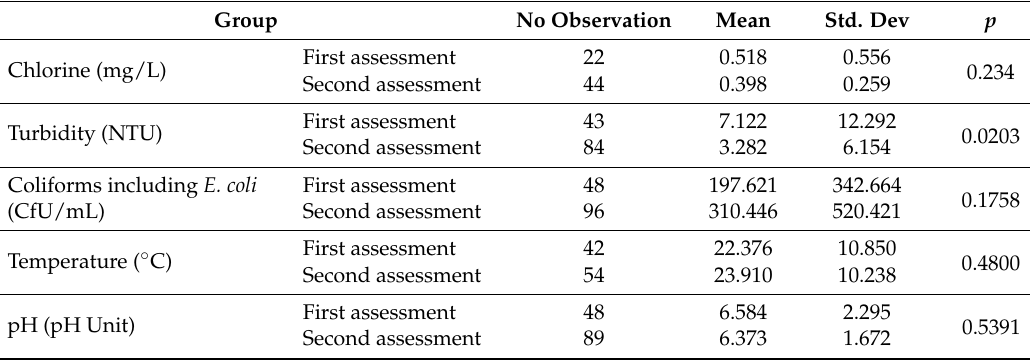
Table 8. Statistical analysis of drinking water collected from different sampling points. Group No Observation Std. Dev